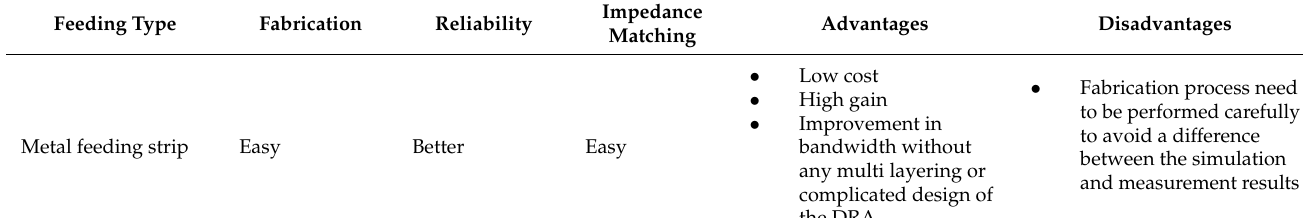
Table 4. Comparison between different feeding